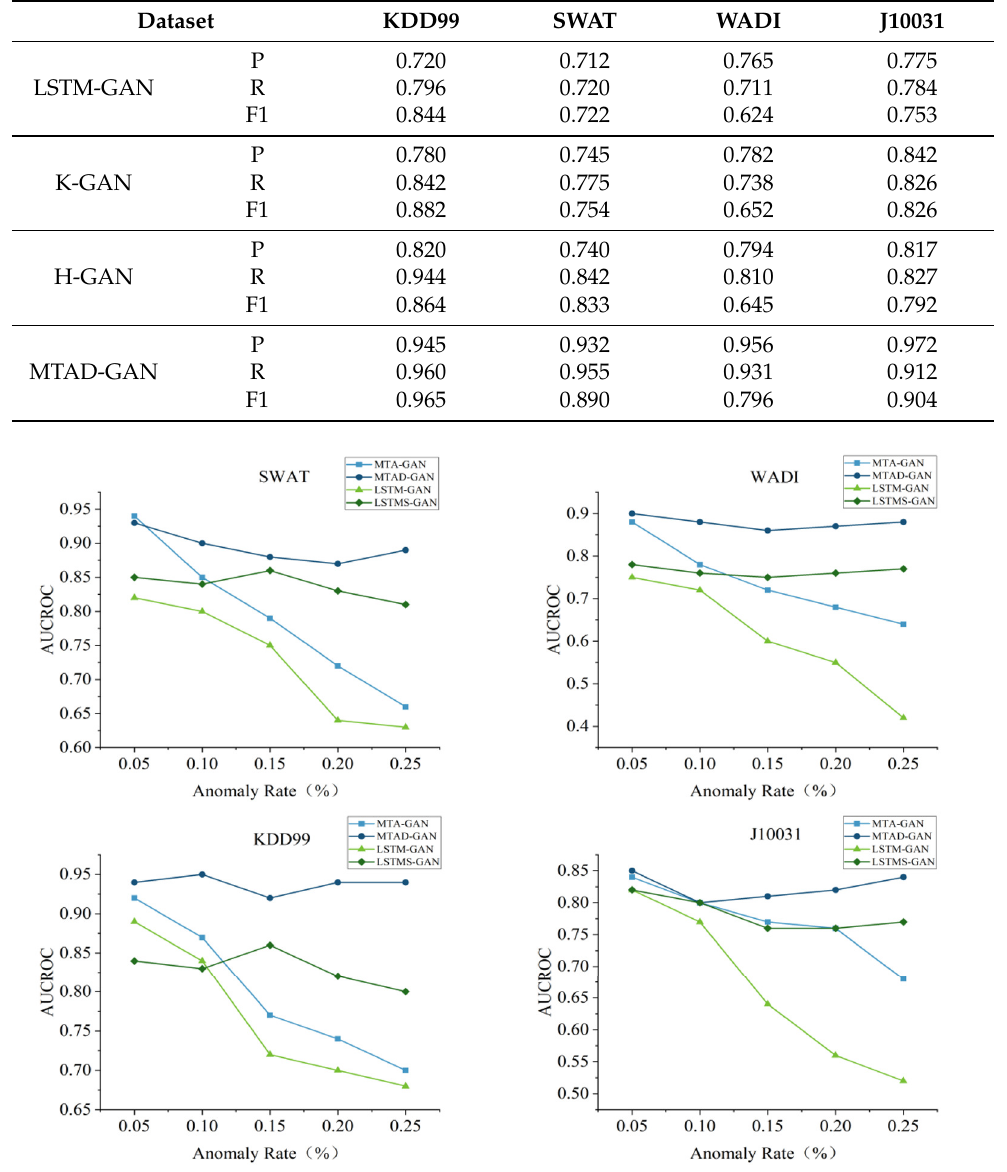
Figure 9. Comparison plot of the loss function ablation experiment